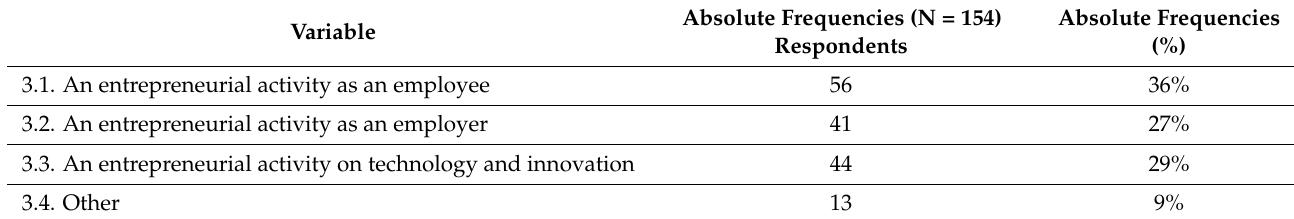
Table 6. What are the reasons for participating in entrepreneurial activities during high school? (Question 3). Variable